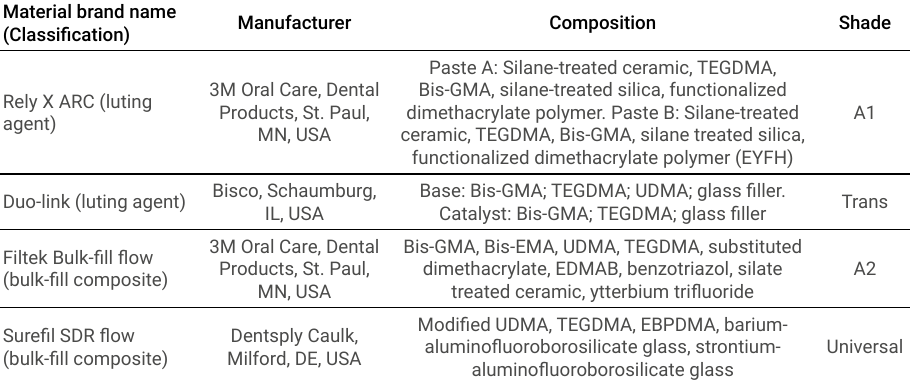
Table 1. Evaluated luting agents and composites and respective manufacturer information. Material brand name